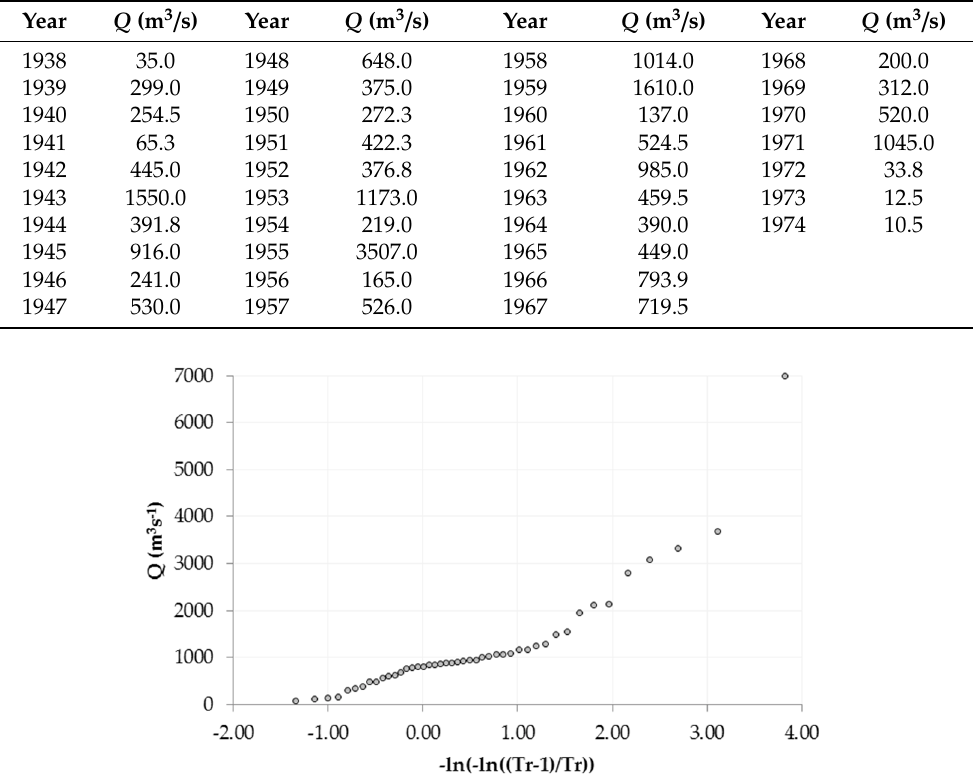
Table 2. Maximum annual flows recorded at hydrometric station 10031.